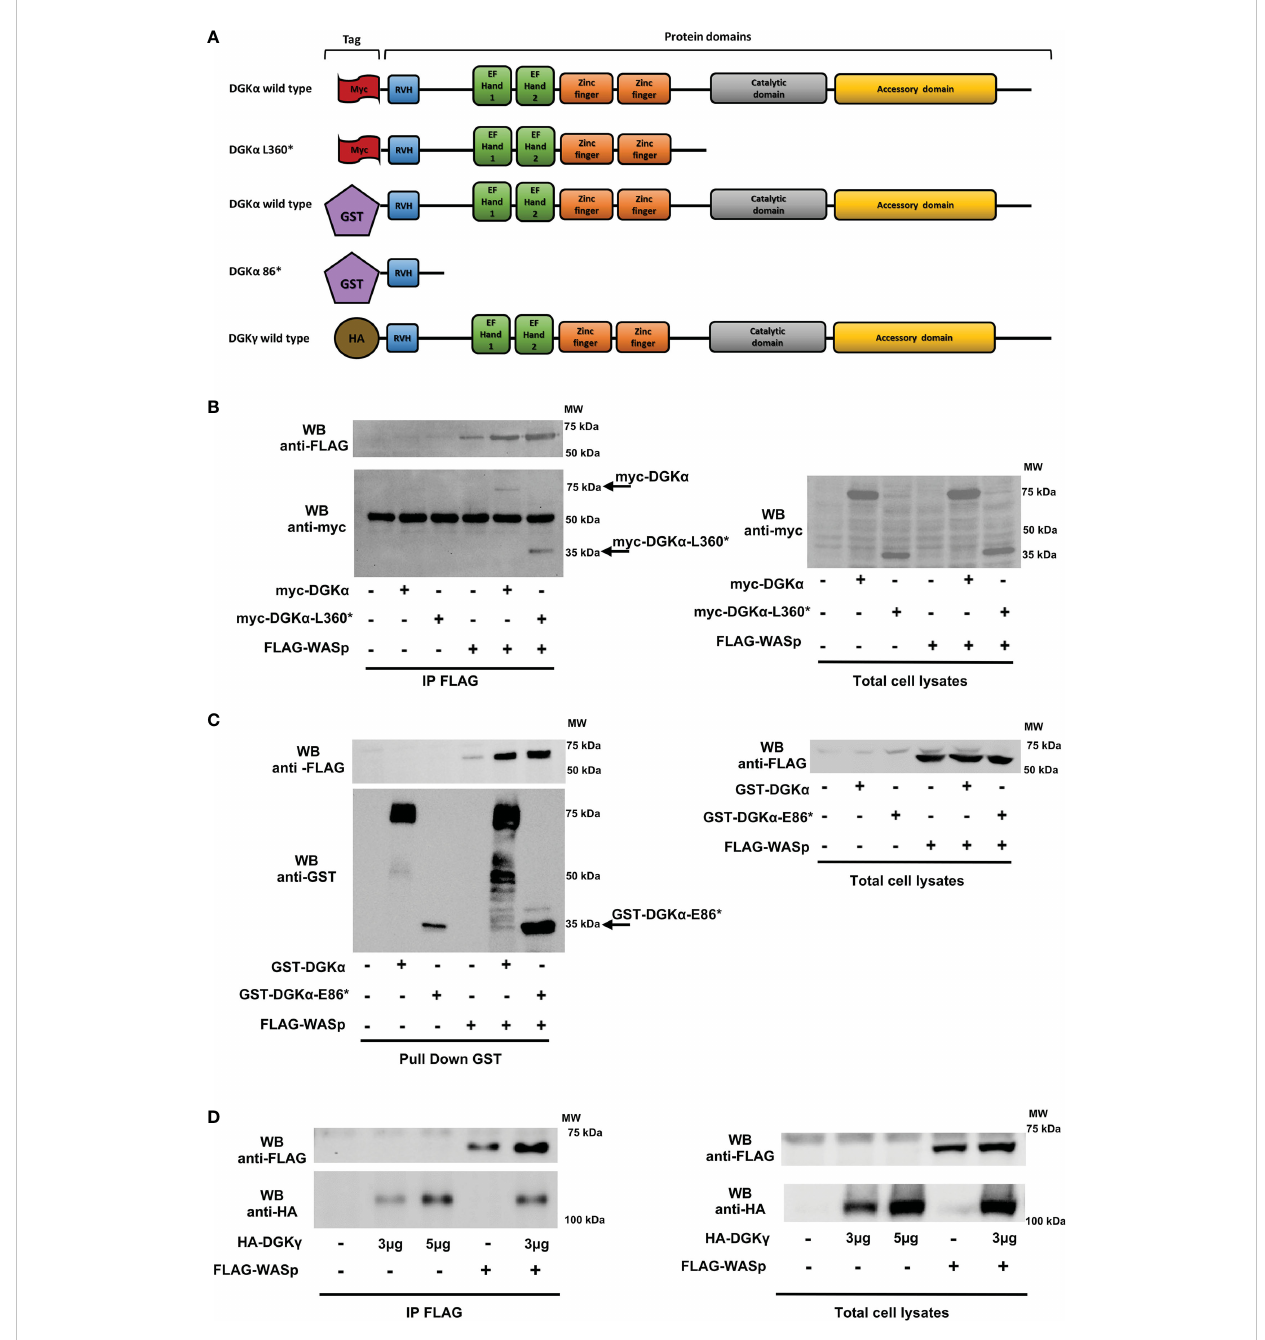
FIGURE 5 DGK a binds to WASp through the recoverin homology domain HEK 293-T cells were co-transfected with the indicated plasmids. 48 hours later, proteins were immunoprecipitated with anti-FLAG ( B and D ) or anti-GST antibody (C) and subsequently analysed by western blotting. (A) DGK a and DGK g constructs used with domains and tags evidenced. (B) Interaction between FLAG-WASp and myc-DGK a WT or myc-DGK a -L360* deletion mutant and the corresponding total cell lysates. (C) Interaction between FLAG-WASp and GST-DGK a or GST-DGK a -E86* deletion mutant and the corresponding total cell lysates. (D) Interaction between FLAG-WASp and HA-DGK g and the corresponding total cell